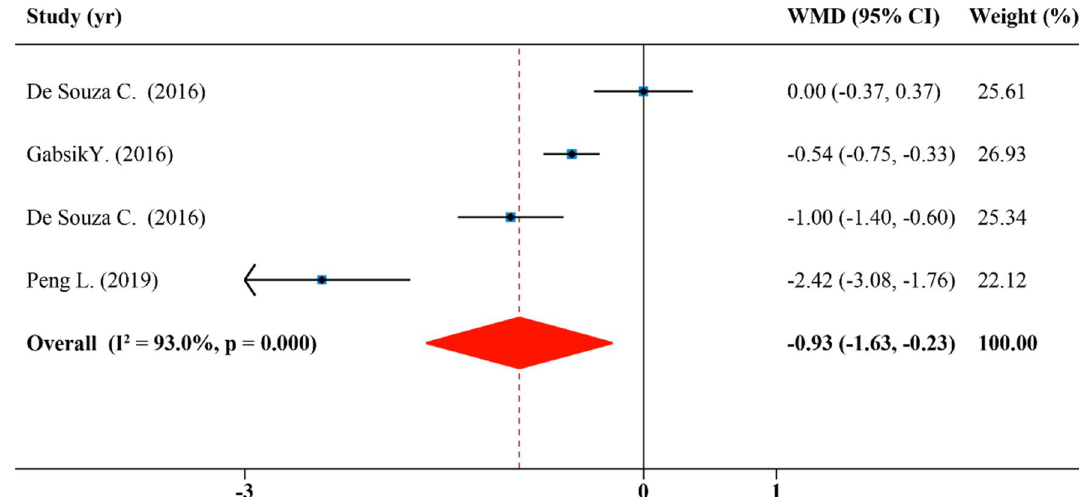
Figure 3. Forest plot showing effects of SFN on liver